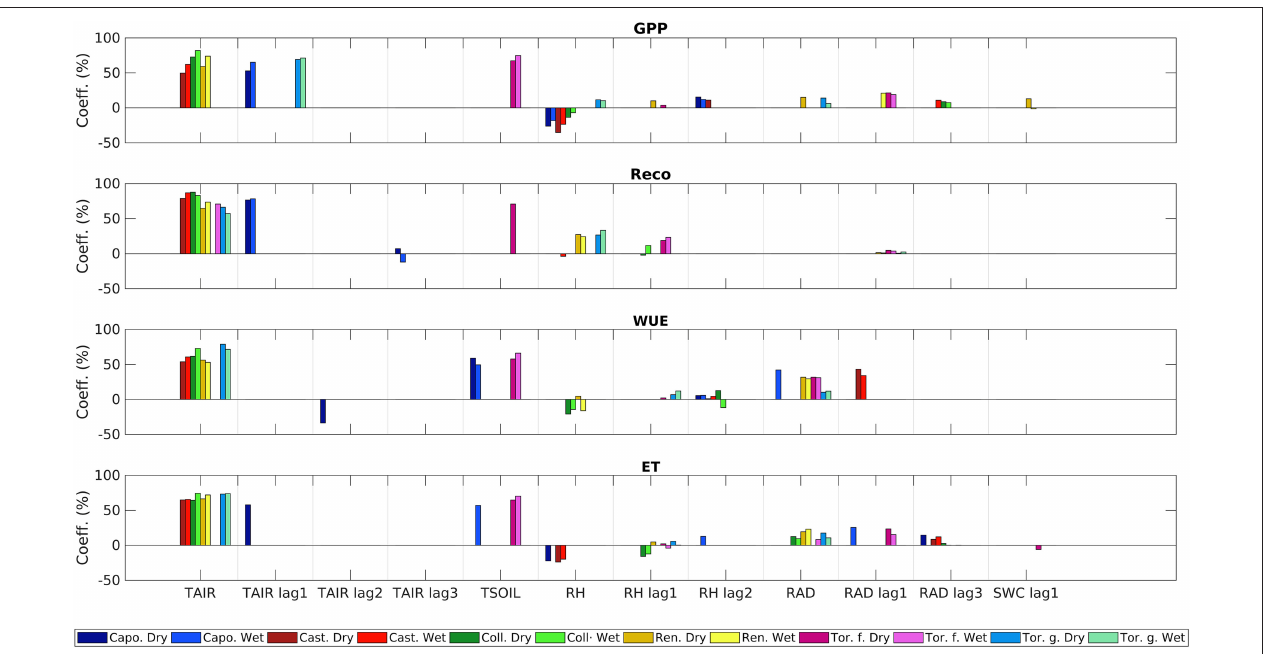
FIGURE 3 | Comparison of the environmental variables affecting Gross Primary Productivity (GPP), Reco, Water Use Efficiency (WUE), and ET. On the X axes are reported the variables with the highest correlation coefficient with the selected principal component. On the Y axis is reported the normalized coefficient of impact with GPP, Reco and WUE. Variables with a coefficient of impact < 10% are not